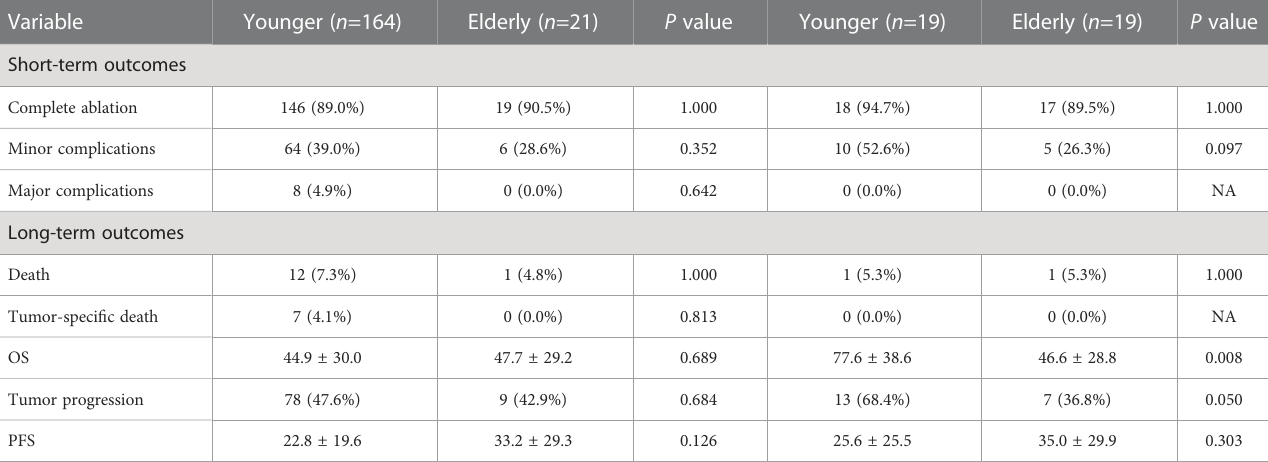
TABLE 4 Prognostic outcomes before and after matching.